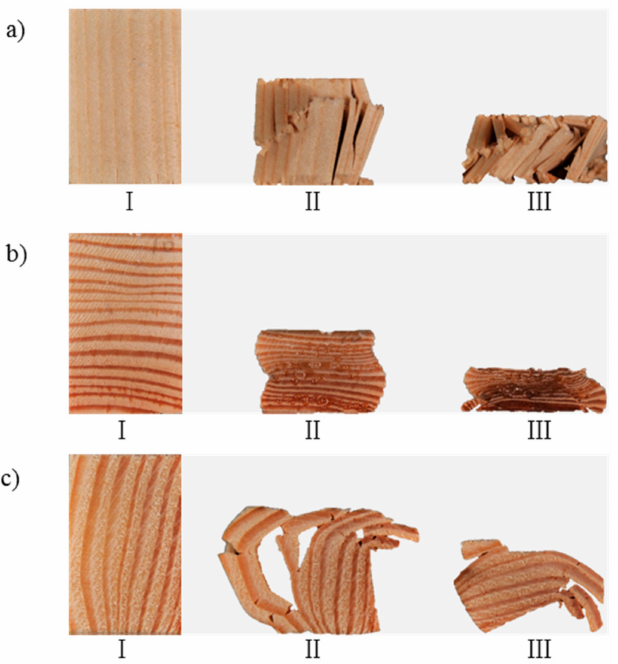
Figure 5. Failure modes in different directions: ( a ) longitudinal direction; ( b ) radial direction; ( c ) tangential direction. Note: I, II, and III indicate different stages during the failure